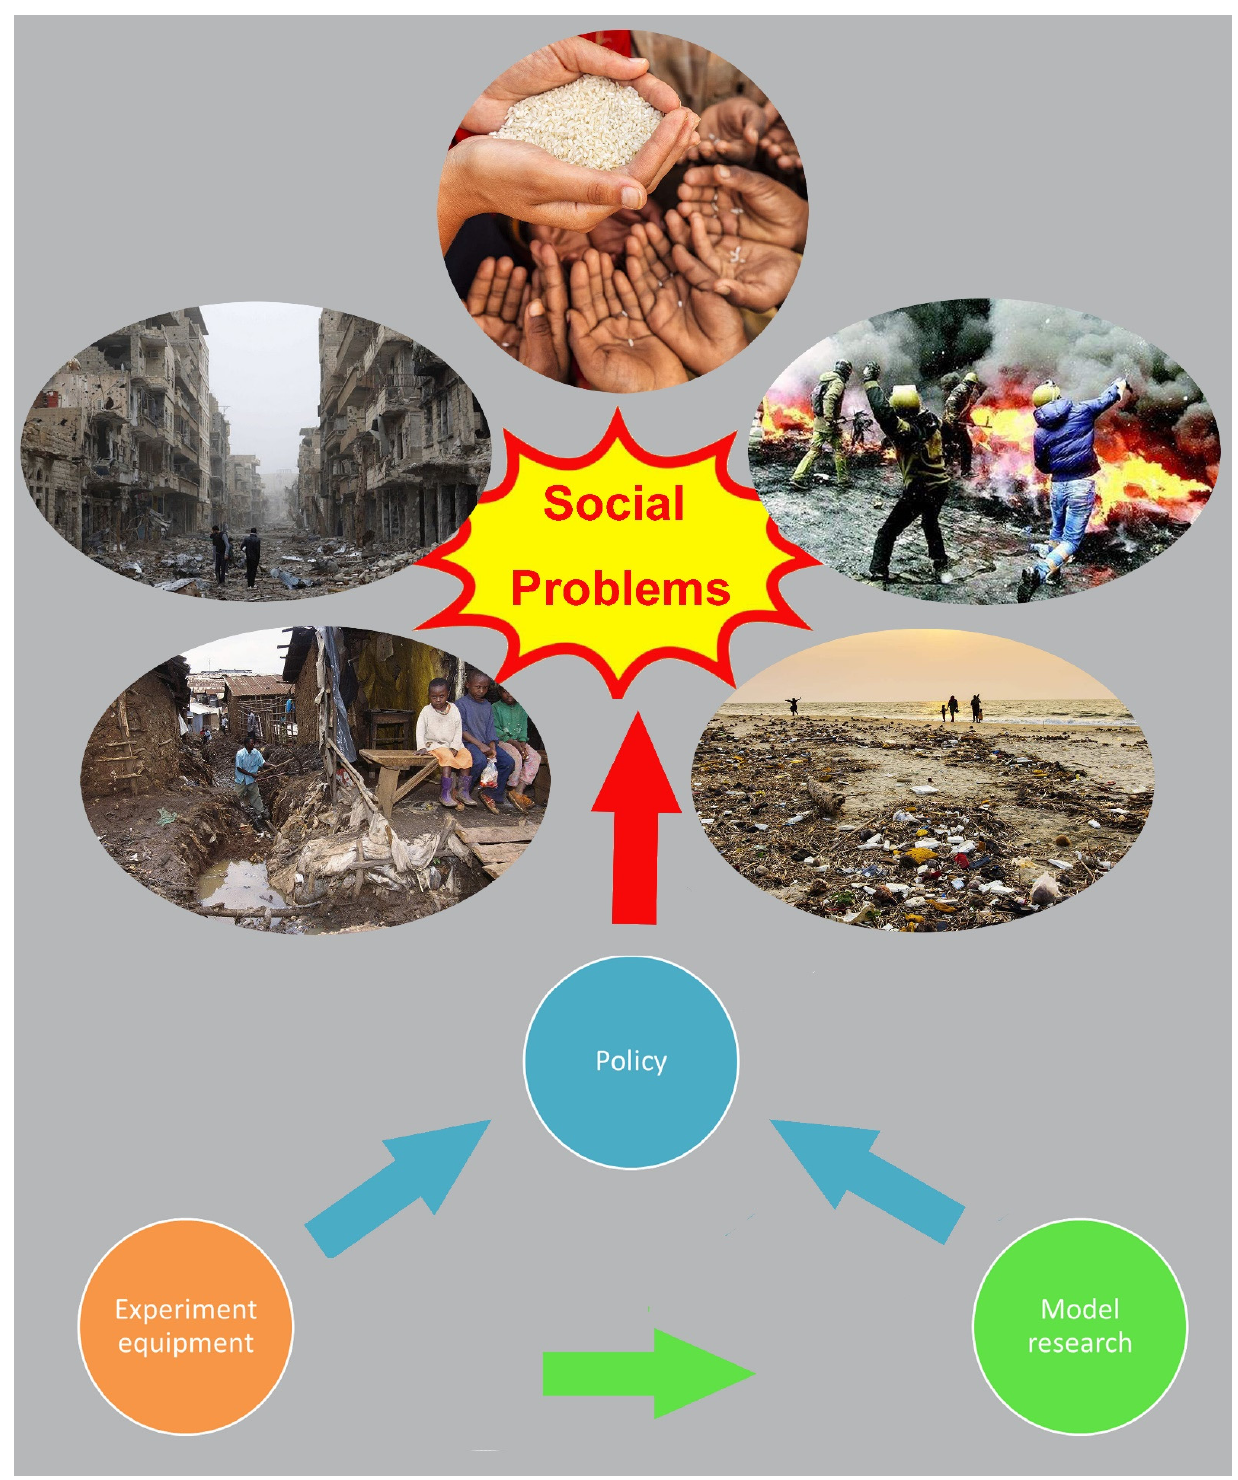
Figure 4. Relationships among policy suggestion, experiment equipment and model research and potential effects of climate changes on social development.